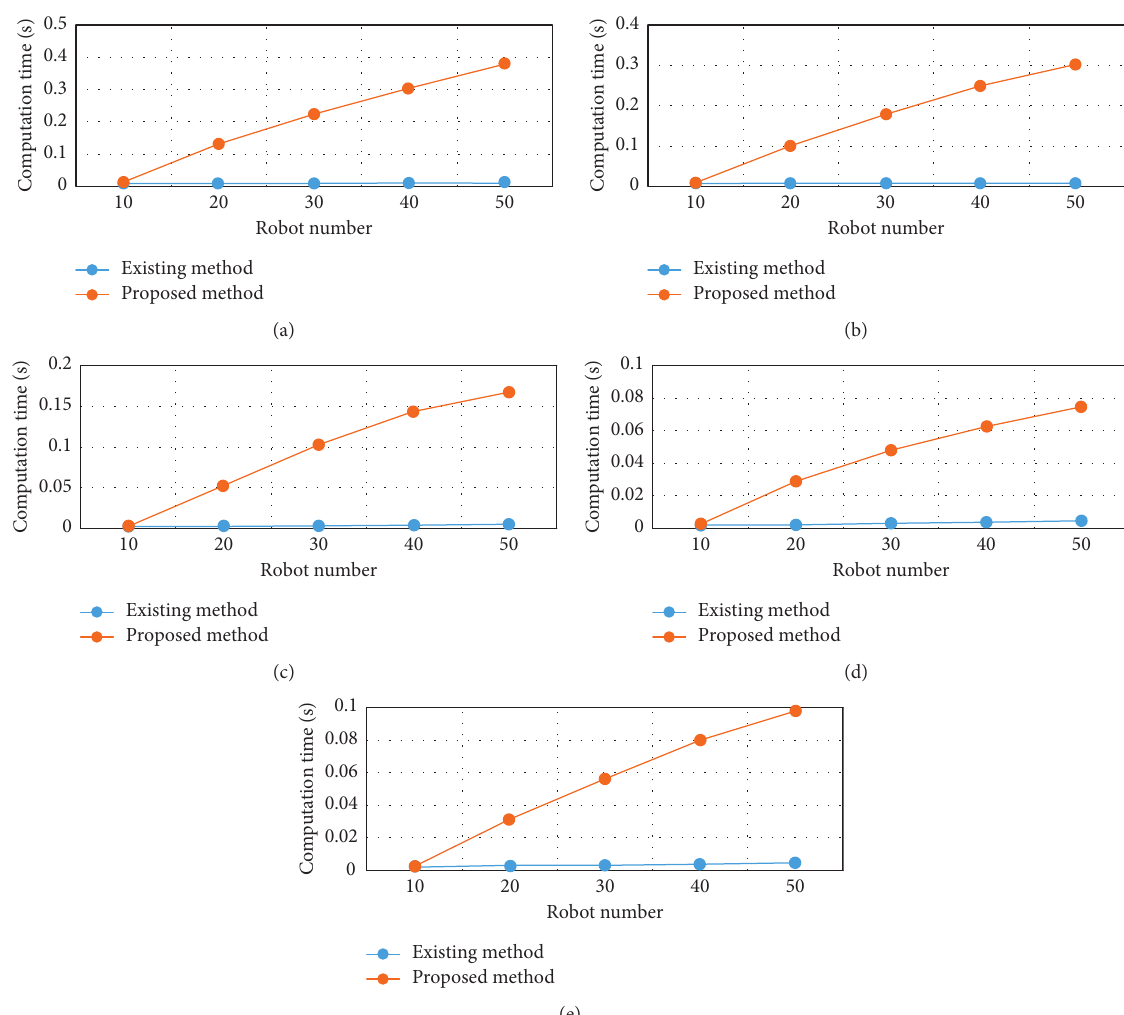
Figure 10: Computation time in a warehouse environment of 50 × 34 4-neighbor grids. (a) p p � u